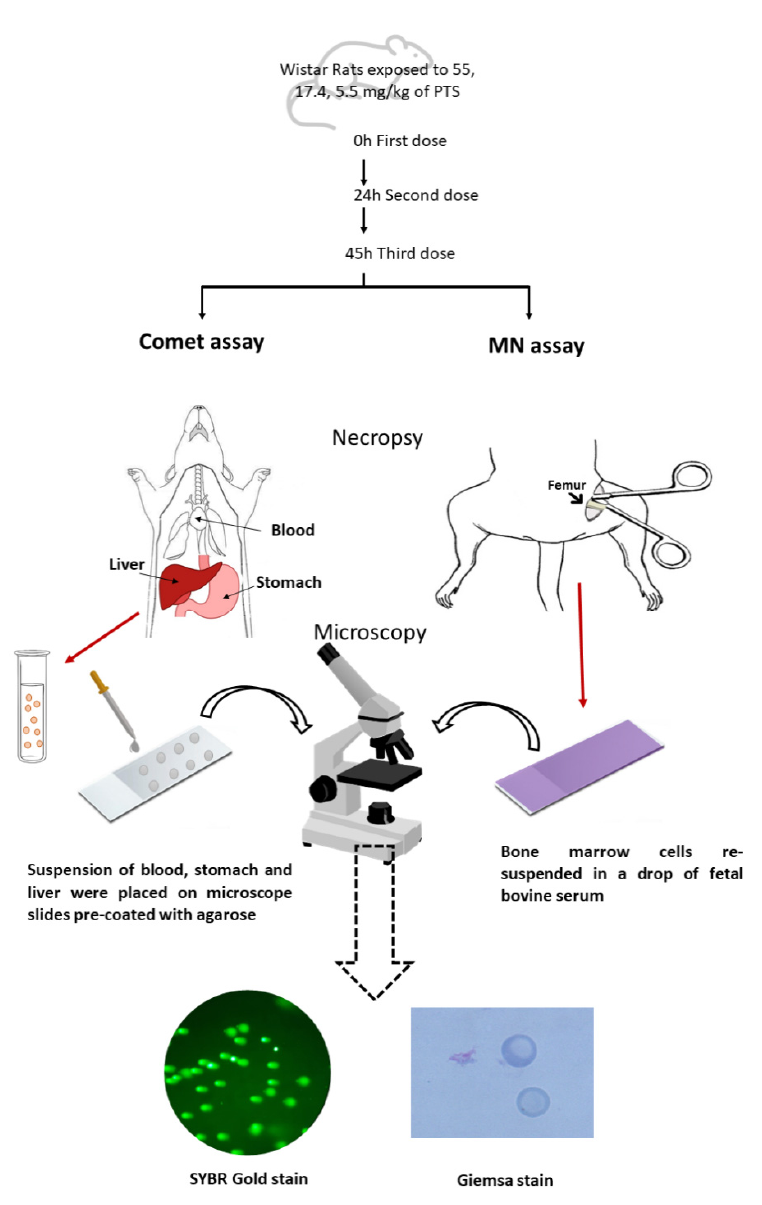
Figure 2. Micronucleus and comet assay schematic diagram on the same animal and its visualization under the optical microscope (fluorescence and bright field).